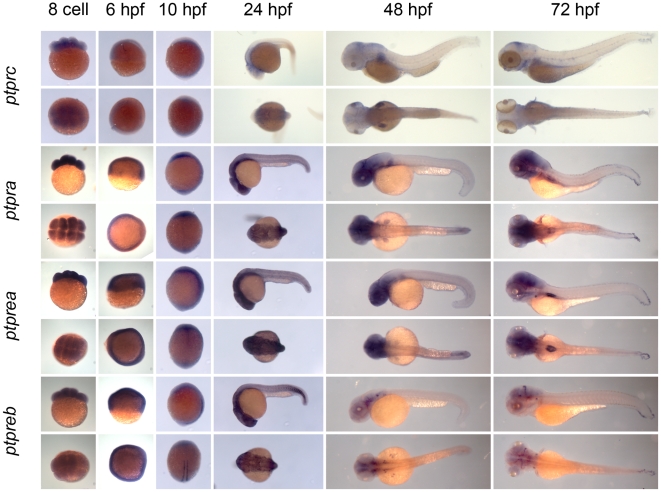
See legend to Fig. 3.